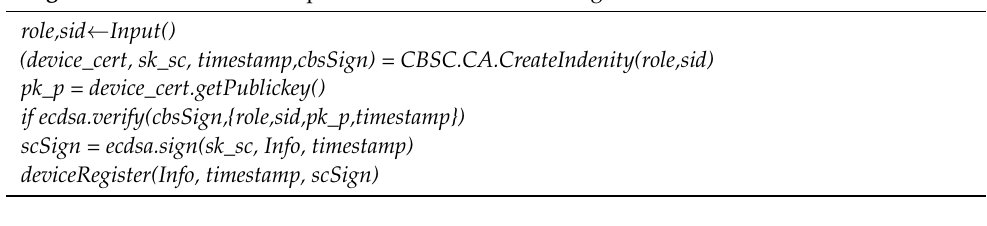
Algorithm 2. The chaincode pseudo-code of the device registration. Algorithm 2 . The chaincode pseudo-code of the device registration.